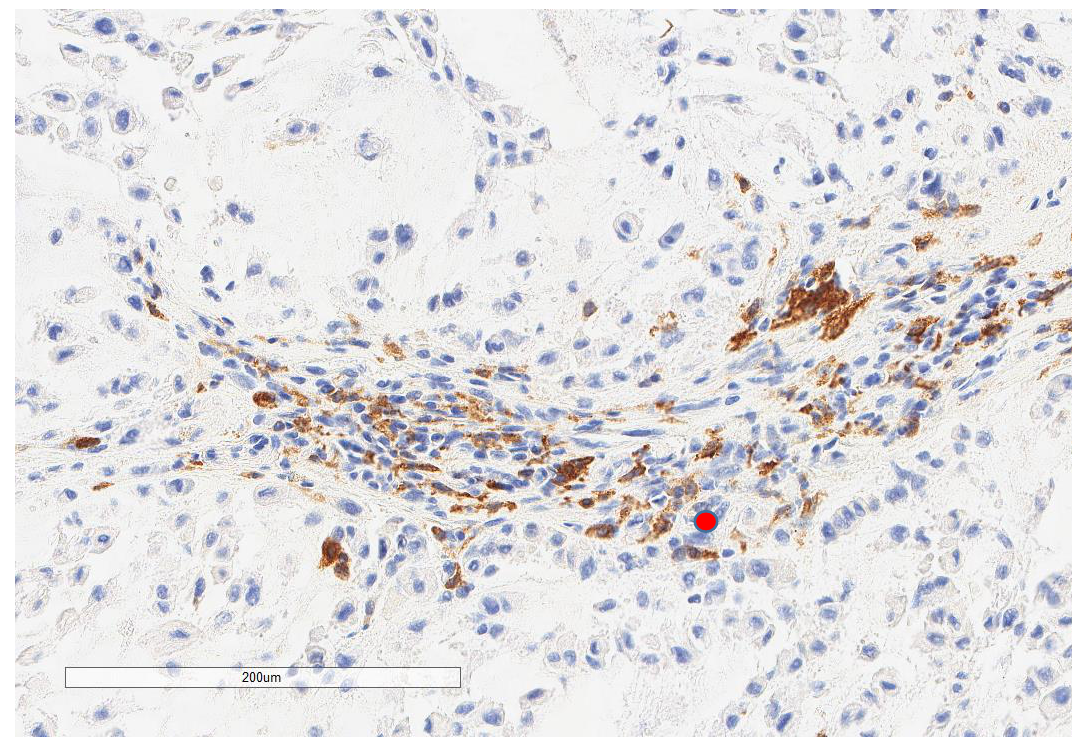
Cancers 2021 , 13 , x FOR PEER REVIEW Figure 2. Representative microscopic image (×200 magnification) of low CD163 expression (red circle). Figure 2. Representative microscopic image ( × 200 magnification) of low CD163 expression (red circle).